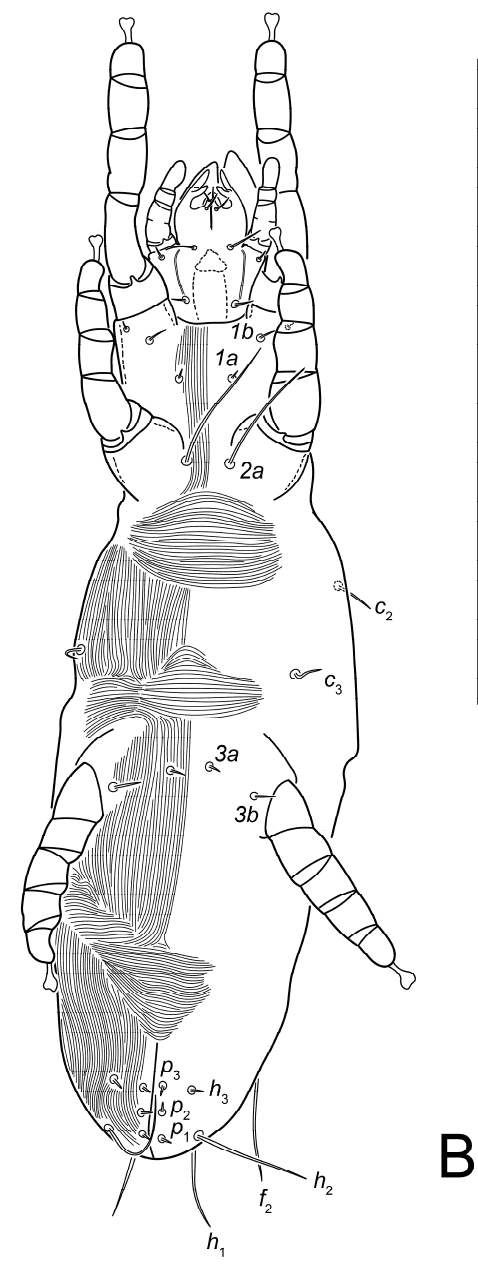
Figure 7. Paralycus daeira sp. n., larva: ( A )—dorsal view; ( B )—ventral view. Scale bar 100 µm.